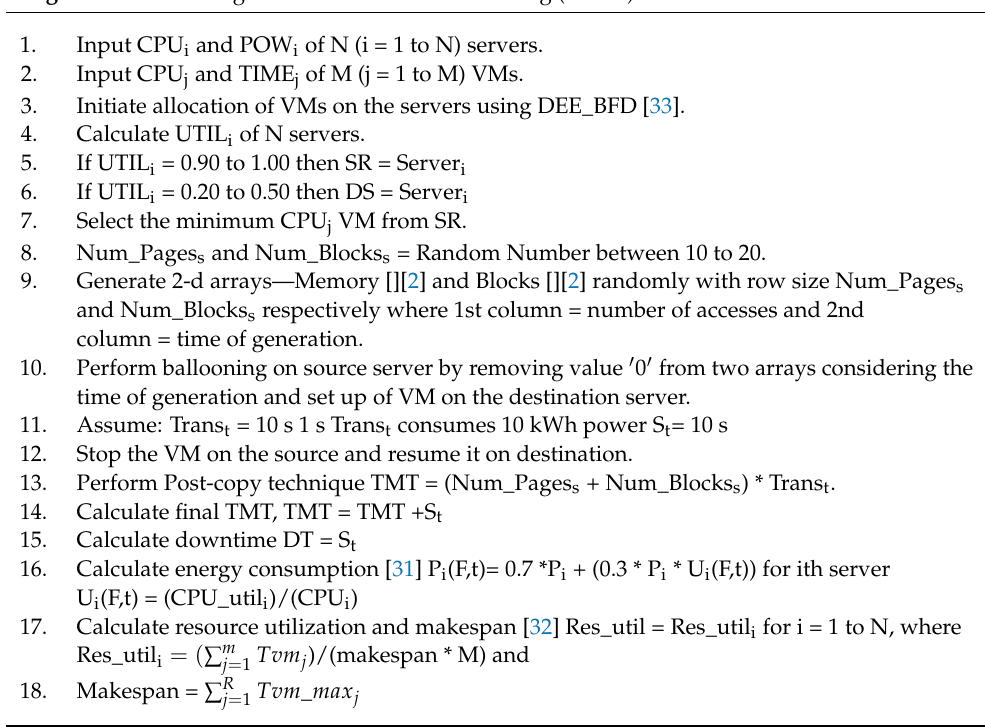
Algorithm 2. Live migration with efficient ballooning